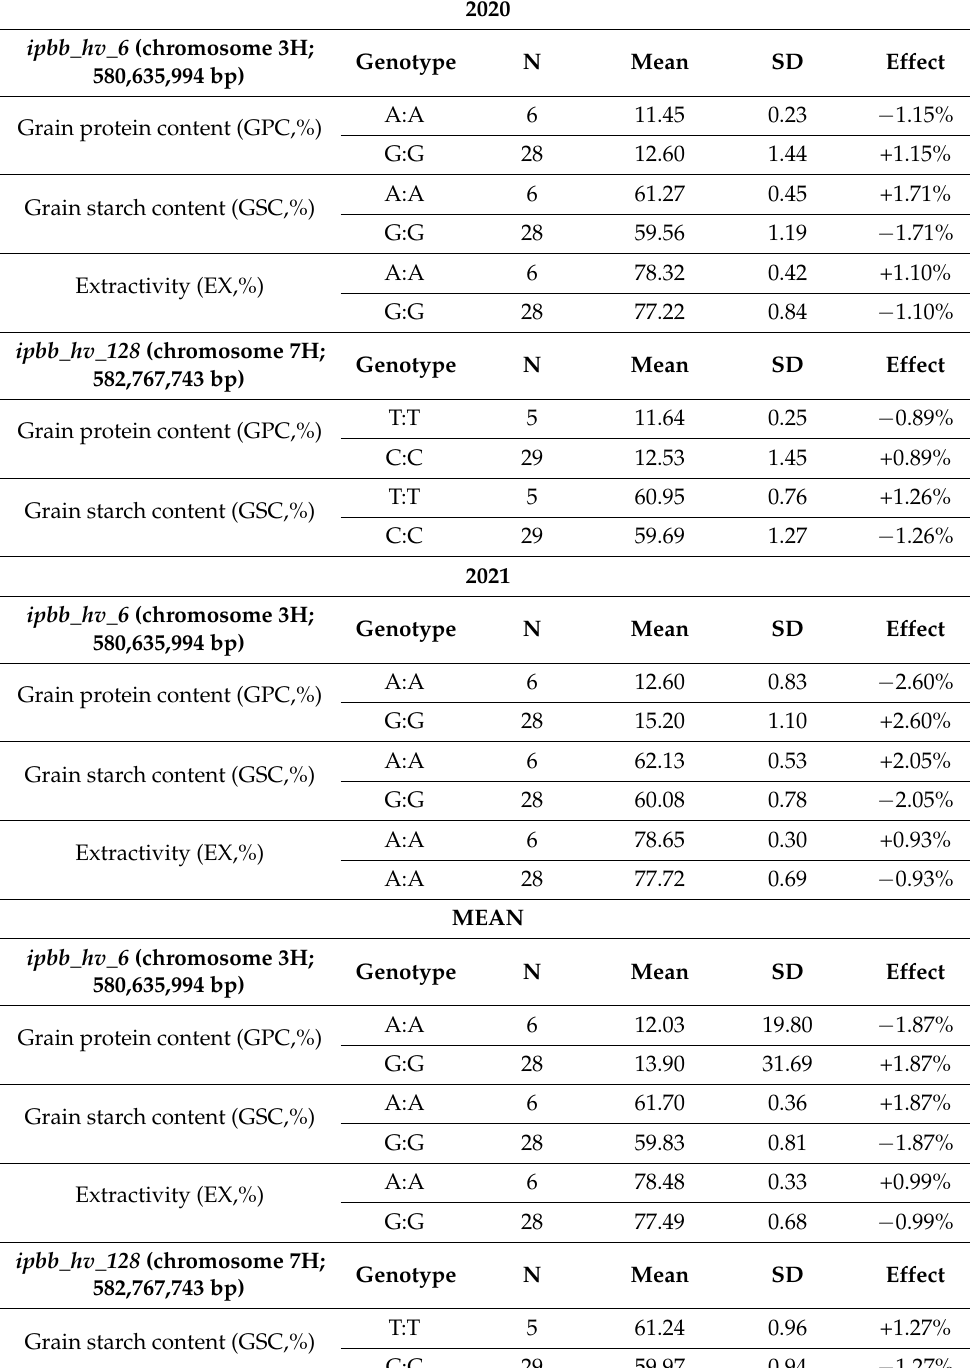
Table 5. Effect of genotypes on grain quality traits in the 34 tested barley breeding